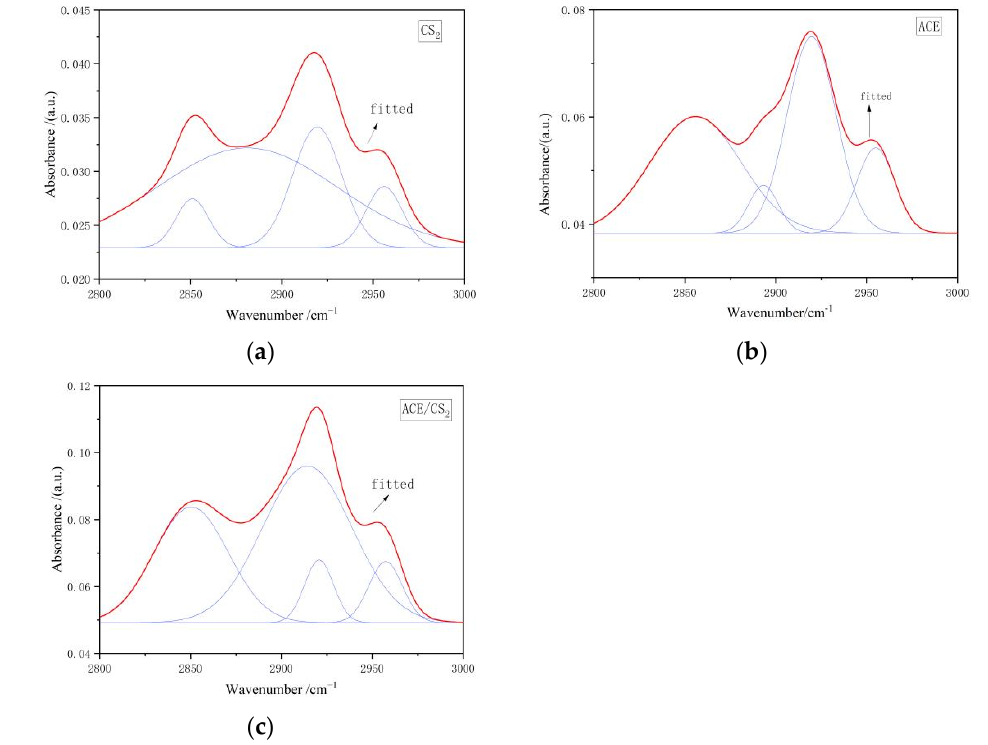
Figure 4. Infrared spectra of extracts in the interval 2800–3000 cm − 1 . (( a ) is the carbon disulphide fit, ( b ) is the acetone fit and ( c ) is the mixed solvent fit. The red line is the fitted curve and the blue line is the sub peak.) Table 4. Infrared spectra of three solvent extracts 2800–3000 cm − 1 split peak fitting ratio of each absorption peak area.